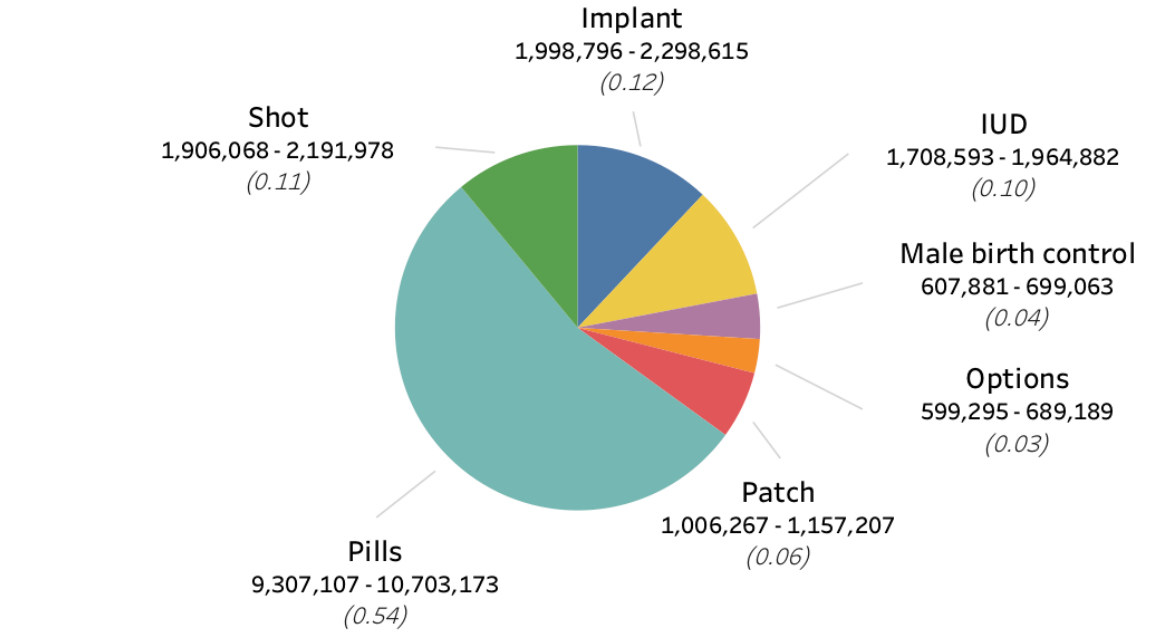
Table 5. Calculations for estimated total search volume for birth control in the United States. ValueSearch item measure 12,393,960Total number of searches for abortion from Planned Parenthood 0.4192RSV a for abortion 0.5808RSV for birth control